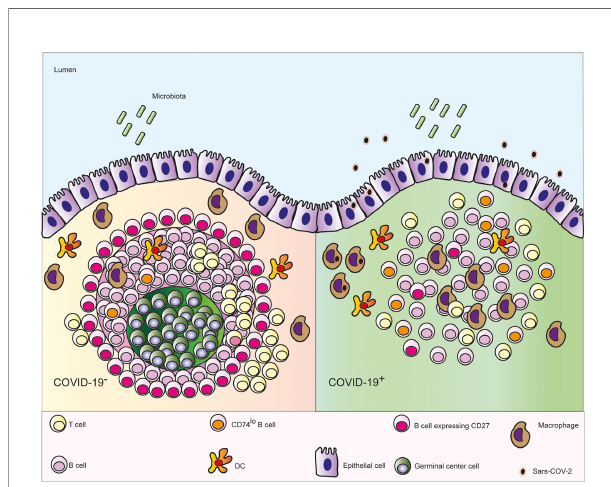
FIGURE 6 | Schematic depicting the microanatomical features identi fi ed in ileal post mortem samples from patients who died with COVID-19: depletion of the germinal centre (GC) in the Peyer ’ s patches, enhanced numbers of follicular macrophages, decreased interaction between B and T cells, fewer CD27 + memory B cells and lower expression CD74 on B